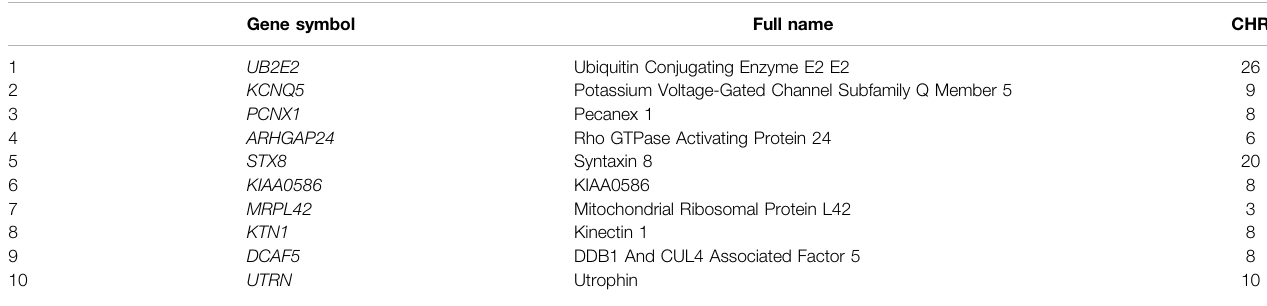
TABLE 4 | The top ten genes from Dorset